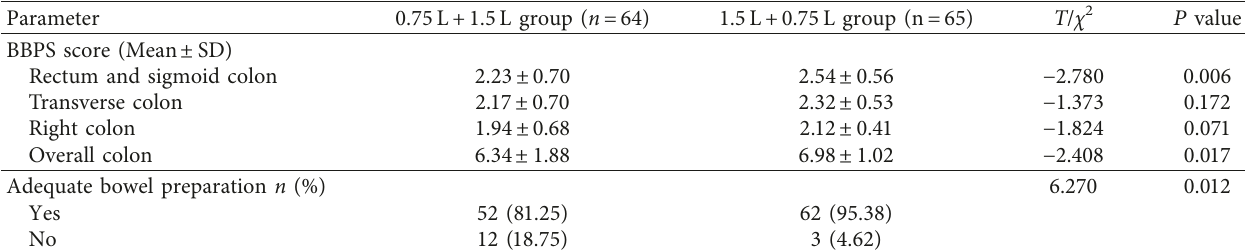
Table 2: Efficacy of bowel cleansing in patients undergoing